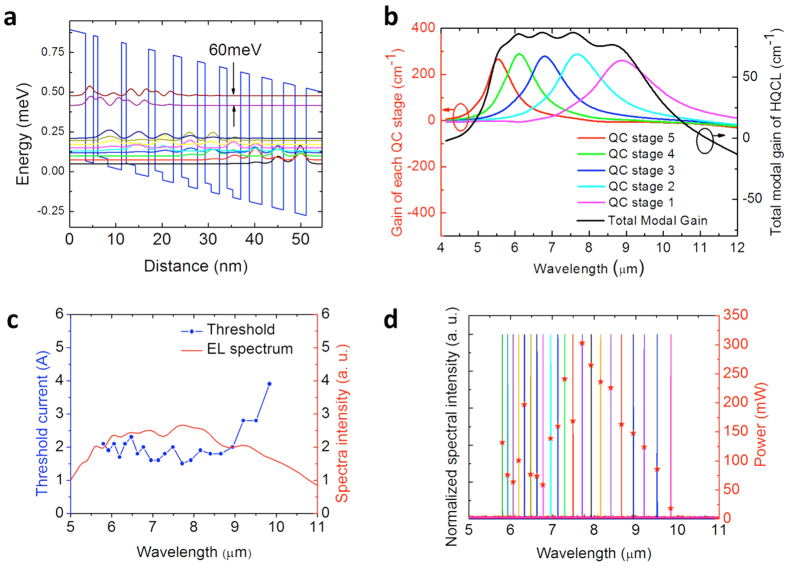
Heterogeneous quantum cascade laser core design.(a) Conduction band diagram and relevant wavefunctions for one emitting stage of a quantum cascade laser based on the Al0.63In0.37As/Ga0.35In0.65As/Ga0.47In0.53As material system. (b) Simulated gain curve of a five-core heterogenous QCL. (c) Overlay plots of EL curve and single mode DFB laser array threshold as a function of wavelength for the five-core QCL design. (d) Overlay plot of compiled emission spectra and single mode peak power as a function of wavelength.